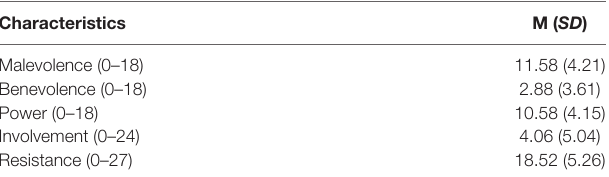
TABLE 3 | Patients’ beliefs, emotions, and behavior about their AHs measured with the VOS-R (N = 33) (VOS-R, Vragenlijst Opvattingen over Stemmen-Revised; in English, BAVQ-R, beliefs about Voices Questionnaire-revised). Characteristics